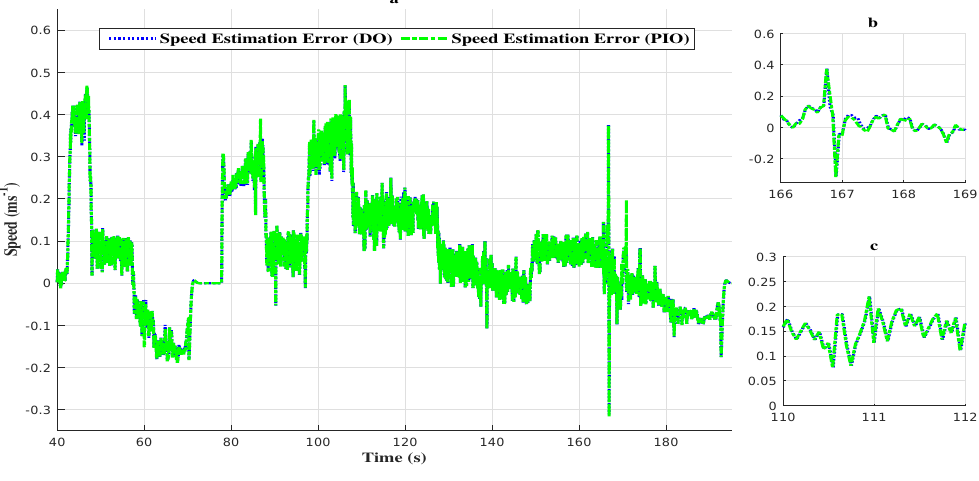
Figure 15. ( a ) Comparison of speed estimation error between the two observers. ( b ) Zoom in at t ∈ [ 166 s,169 s ] . ( c ) Zoom in at t ∈ [ 110 s,112 s